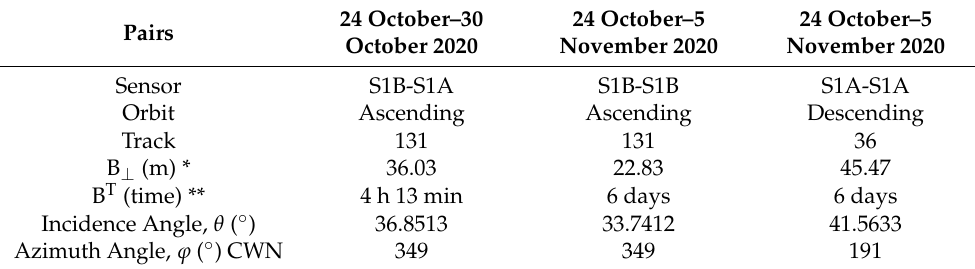
Table 3. Synthetic Aperture Radar (SAR) interferometric pairs.